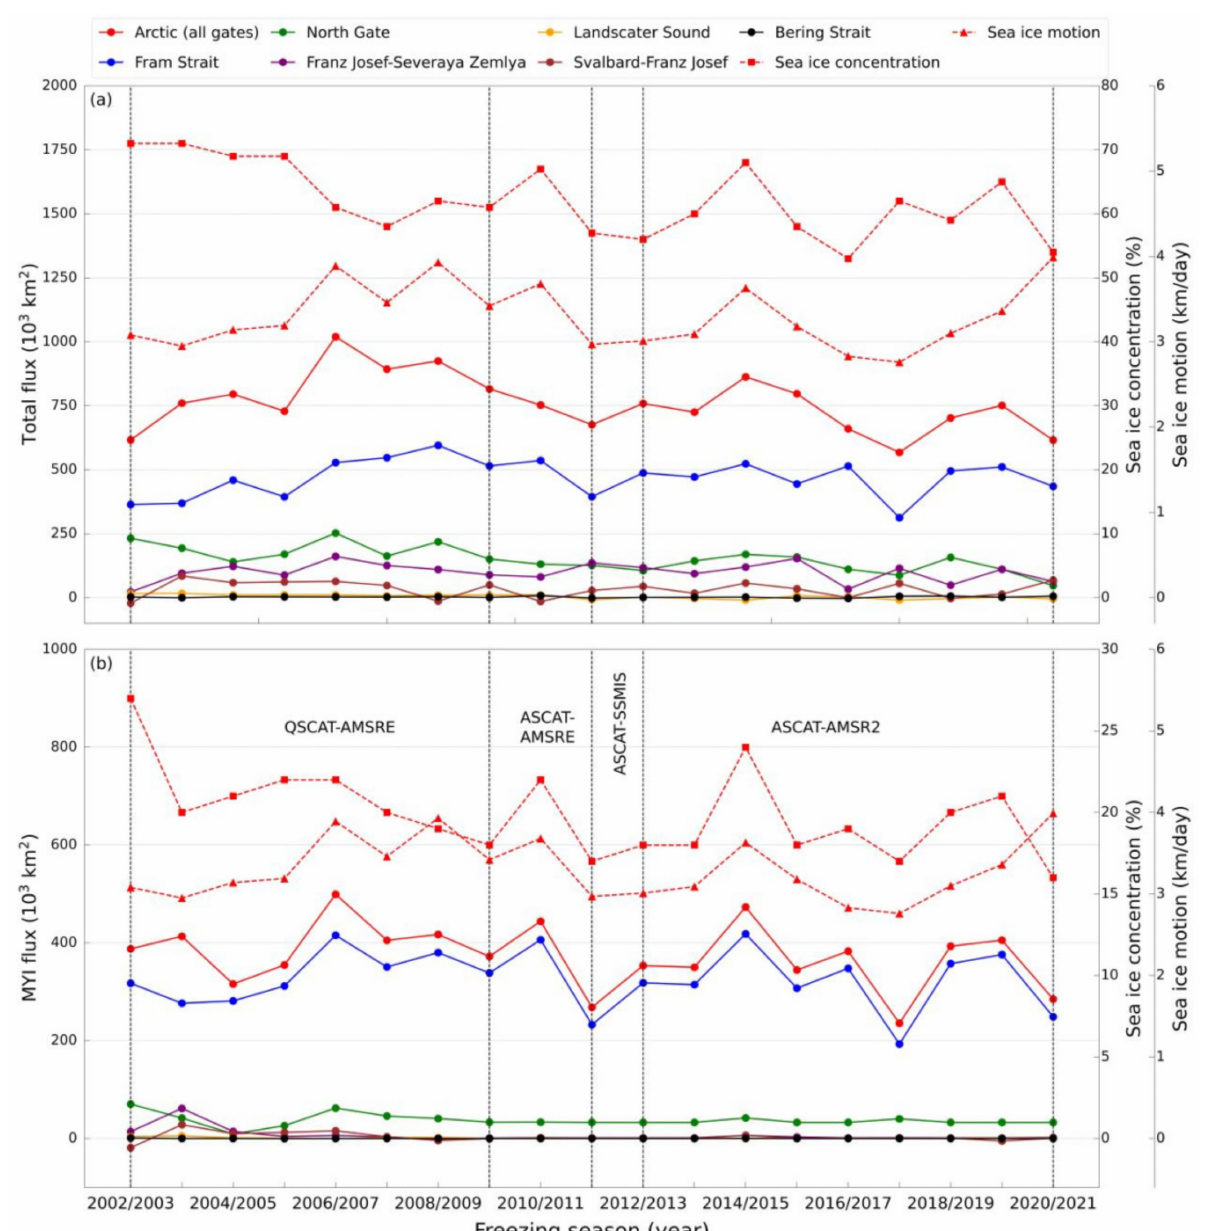
Figure 4. Winter areal flux of ( a ) total sea ice and ( b ) MYI for each fluxgate. Red dotted lines with rectangle and triangle markers represent the mean sea ice concentration and motion of the Arctic,